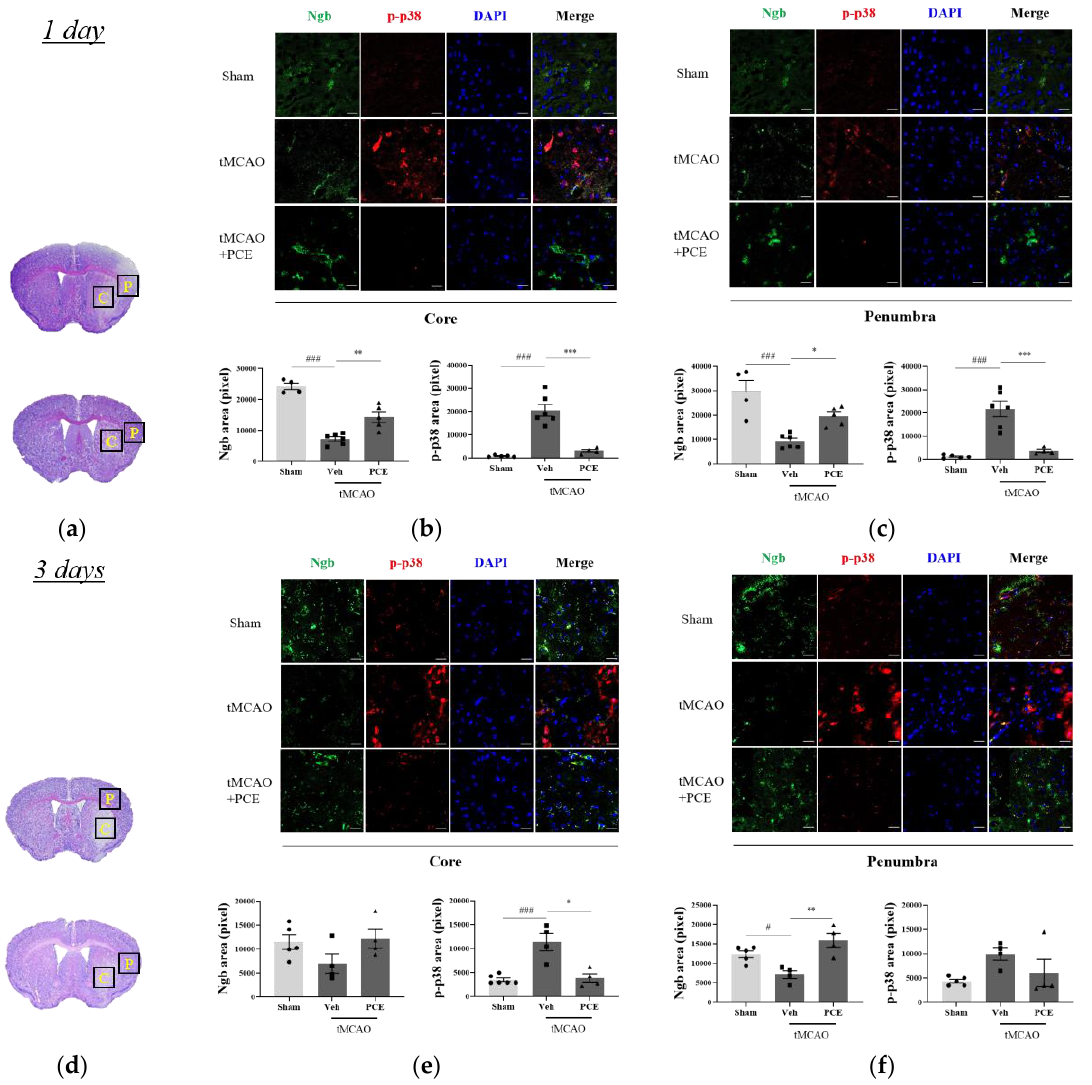
Figure 7. Immunofluorescence staining indicates changes in Ngb and activated p38 levels in the ischemic stroke brain. ( a , d ) Representative images of Nissl staining of the areas that were selected for quantifying Ngb and p-p38 in the ipsilateral brain area 1 day ( a – c ) and 3 days ( d – f ) post-stroke, respectively. Black solid line and yellow-labeled boxes (1 × 1 mm 2 square field) outline the core and penumbra (C and P) infarct regions. ( b , c , e , f ) Representative images and quantification of Ngb (green) and p-p38 (red) staining in the ipsilateral area post-tMCAO in mice. Treatment with PCE resulted in significant increases in Ngb and decreases in activated p38 in comparison with the vehicle-treated tMCAO group. Data are presented as mean ± SEM. White scale bar = 20 μm. ***, ### p < 0.001, ** p < 0.01, *, # p < 0.05. Statistical significance was determined using one-way ANOVA, followed by Tukey’s multiple comparisons test (1 day post-stroke, n = 5; 3 days post-stroke, n = 4).